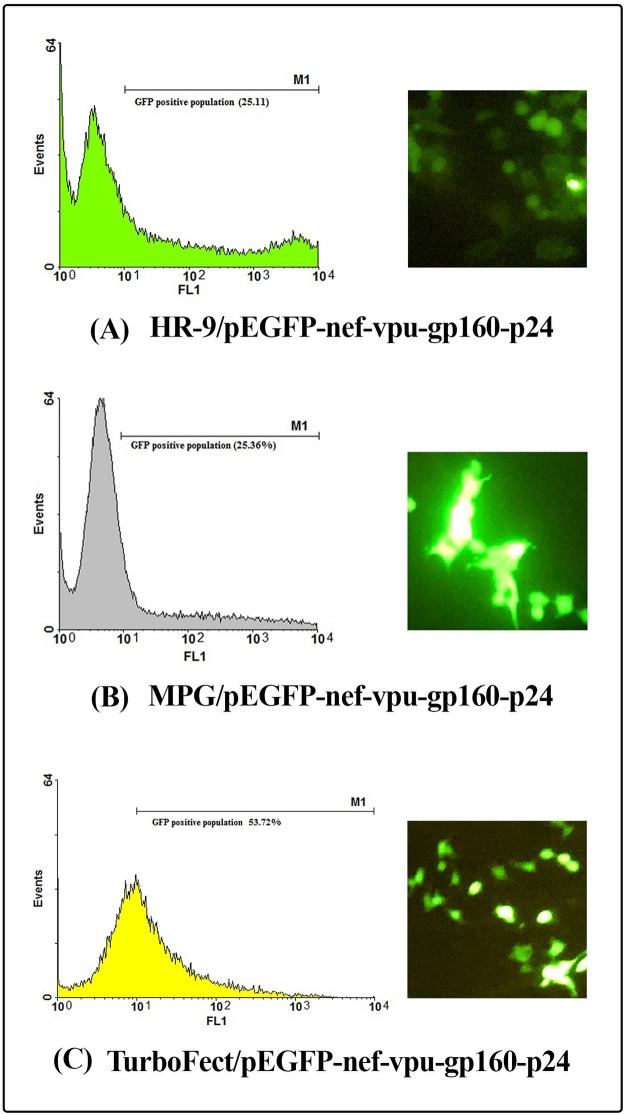
Transfection efficiency of the CPP/DNA complexes using flow cytometry and fluorescence microscopy.(A) the HR9/pEGFP-nef-vpu-gp160-p24 complexes, (B) the MPG/pEGFP-nef-vpu-gp160-p24 complexes, (C) the TurboFect/pEGFP-nef-vpu-gp160-p24 complexes.